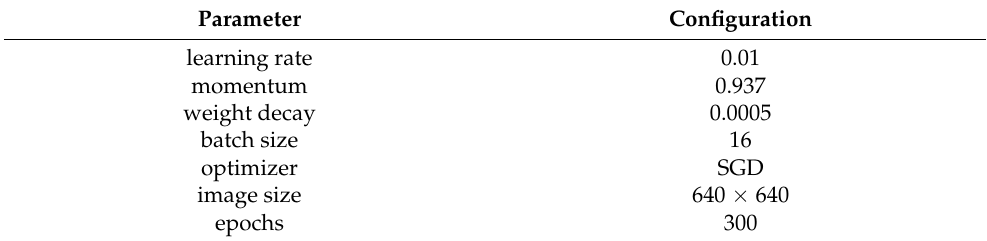
Table 1. Experimental